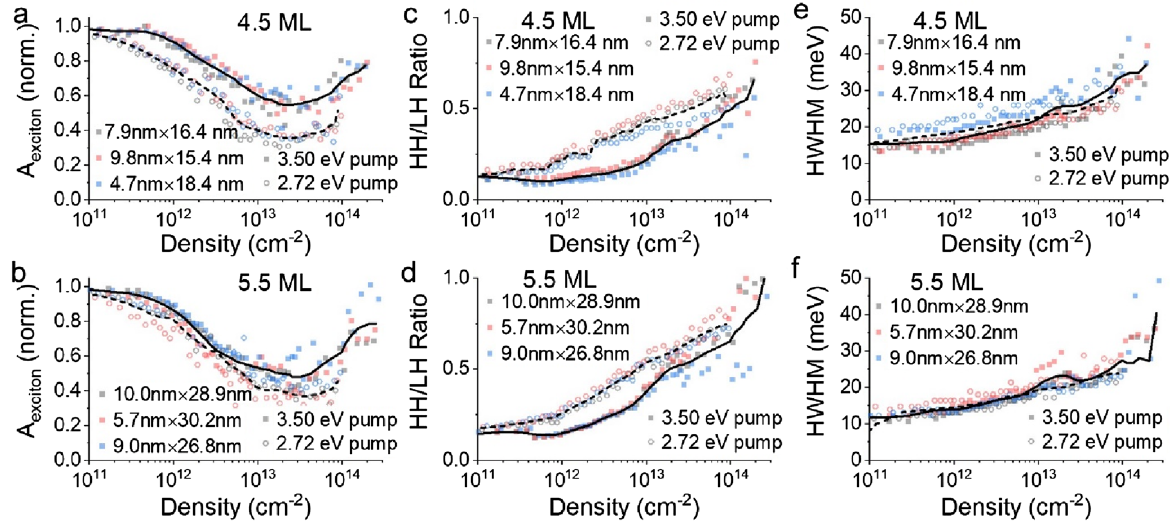
Figure 3. ( a , b ) Normalized exciton absorption intensity for three ( a ) 4.5 and ( b ) 5.5 ML CQW samples as a function of photogenerated sheet density. Each data point is extracted from a transient absorption spectrum collected at 3 ps pump-probe delay for many powers of 2.72 eV and 3.50 eV pump light. ( c , d ) Ratio of heavy hole and light hole bleach signals as a function of photogenerated sheet densities for the same ( c ) 4.5 and ( d ) 5.5 ML samples. ( e , f ) Half-width at half-maximum (HWHM) of the HH bleach feature from the transient absorption spectrum (ΔA) plotted against photogenerated sheet densities of the same ( e ) 4.5 and ( f ) 5.5 ML samples. In all cases, data for measurements with 3.50 eV pump are shown in solid symbols and data for 2.72 eV pump measurements are shown in open symbols. A solid line represents a smoothed average of 3.50 eV pump experiments and a dashed line corresponds to the smoothed average of 2.72 eV pump.